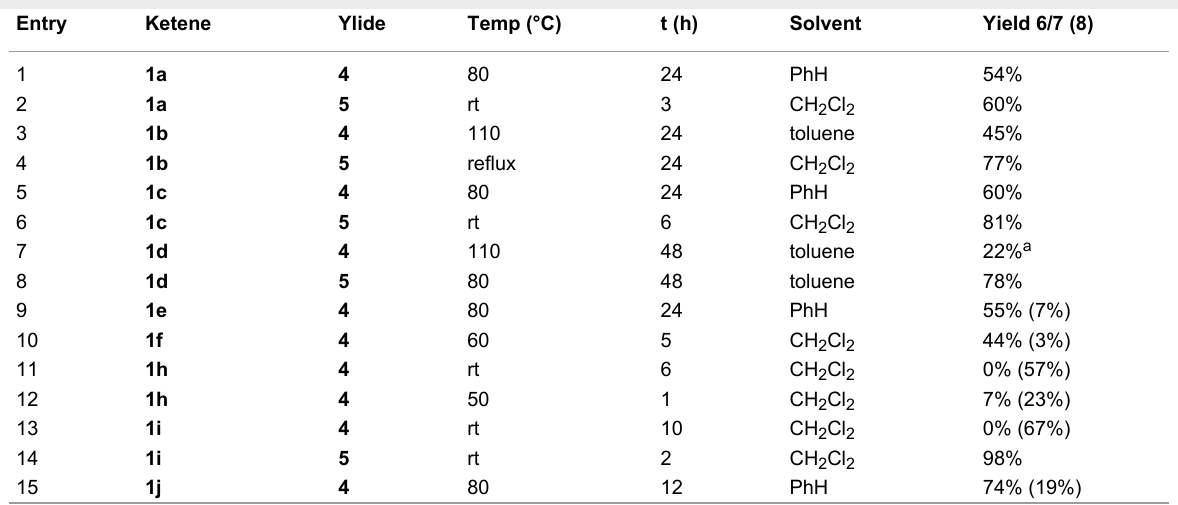
Table 2: Reaction of substituted silylketenes with ester-stabilised phosphoranes Entry